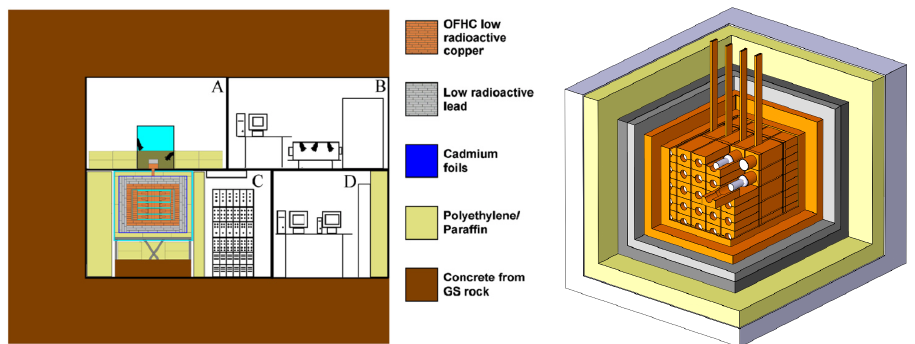
Figure 1. Left : schematic view of the building hosting the DAMA/LIBRA apparatus (not to scale). About 1 m concrete (made from the Gran Sasso rock material) almost fully surrounds (mostly outside the building) the apparatus. In particular, the room A hosts the glove-box for calibrations; some facilities are in the room B; the sensitive parts of the apparatus are in the room C inside the multi- component shield as well as the electronics; the computer for DAQ is in the room D. Right : schematic view of the passive shield of the DAMA/LIBRA apparatus. Reprinted with permission from [18]. Copyright 2008